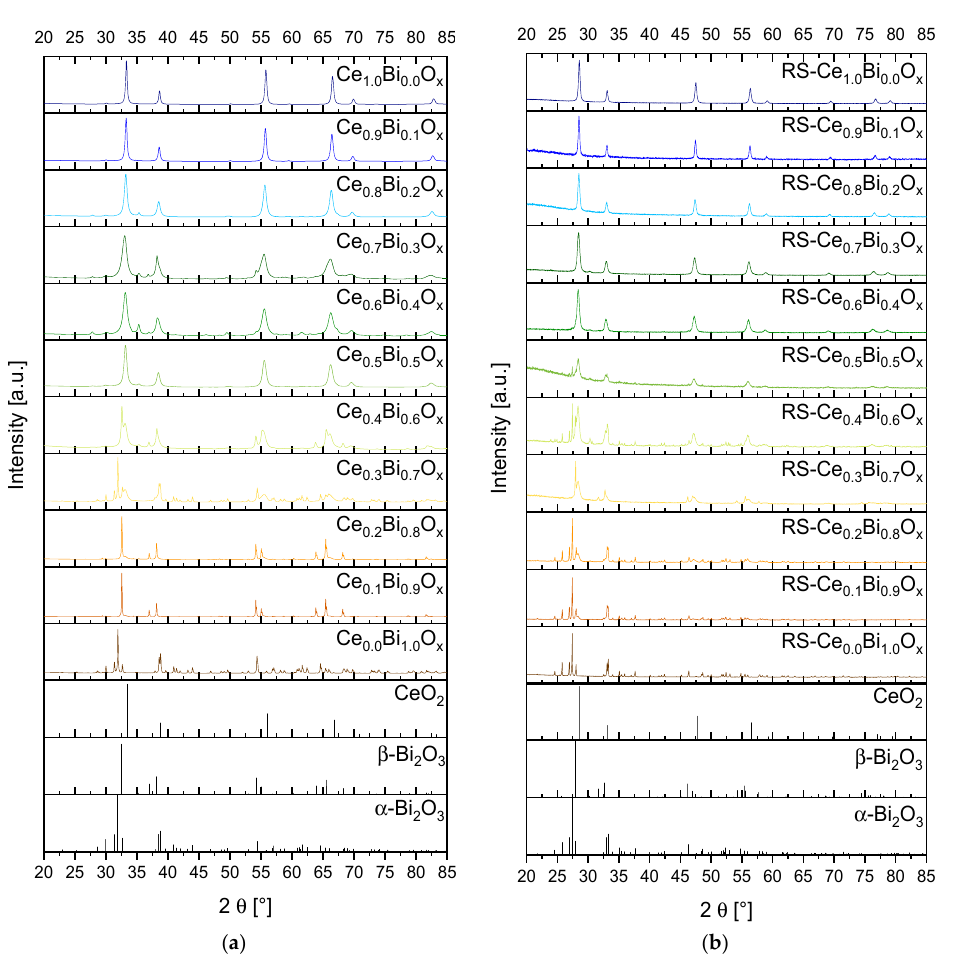
Figure 2. Powder X-ray diffraction (PXRD) pattern of the synthesized Bi-Ce mixed oxides with varying Bi-Ce molar ratios in 10 mol% steps. Oxides calcined at T = 800 °C. ( a ) Normal synthesis route. Measured with Co-K α radiation, λ = 178.92 nm; ( b ) Reverse strike synthesis route. Measured with Cu-K α radiation, λ = 154.06 nm. Reference files for CeO 2 : ICDD#75-76; α -Bi 2 O 3 : ICDD#71-2274; β -Bi 2 O 3 : ICDD#78-1793.